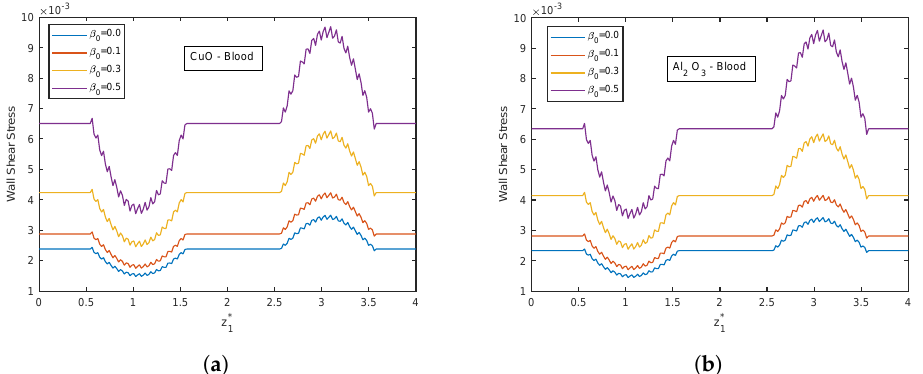
Figure 19. Wall shear stress profiles of viscosity parameter β 0 for ( a ) CuO-nanoparticles, ( b ) Al 2 O 3 - nanoparticles at t ∗ = 1.2. 1